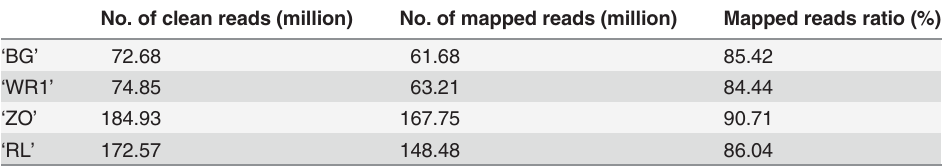
Table 1. Statistics of RNA-Seq clean reads and mapped reads ratio against in the lotus reference genome. No. of clean reads (million) No. of mapped reads (million)